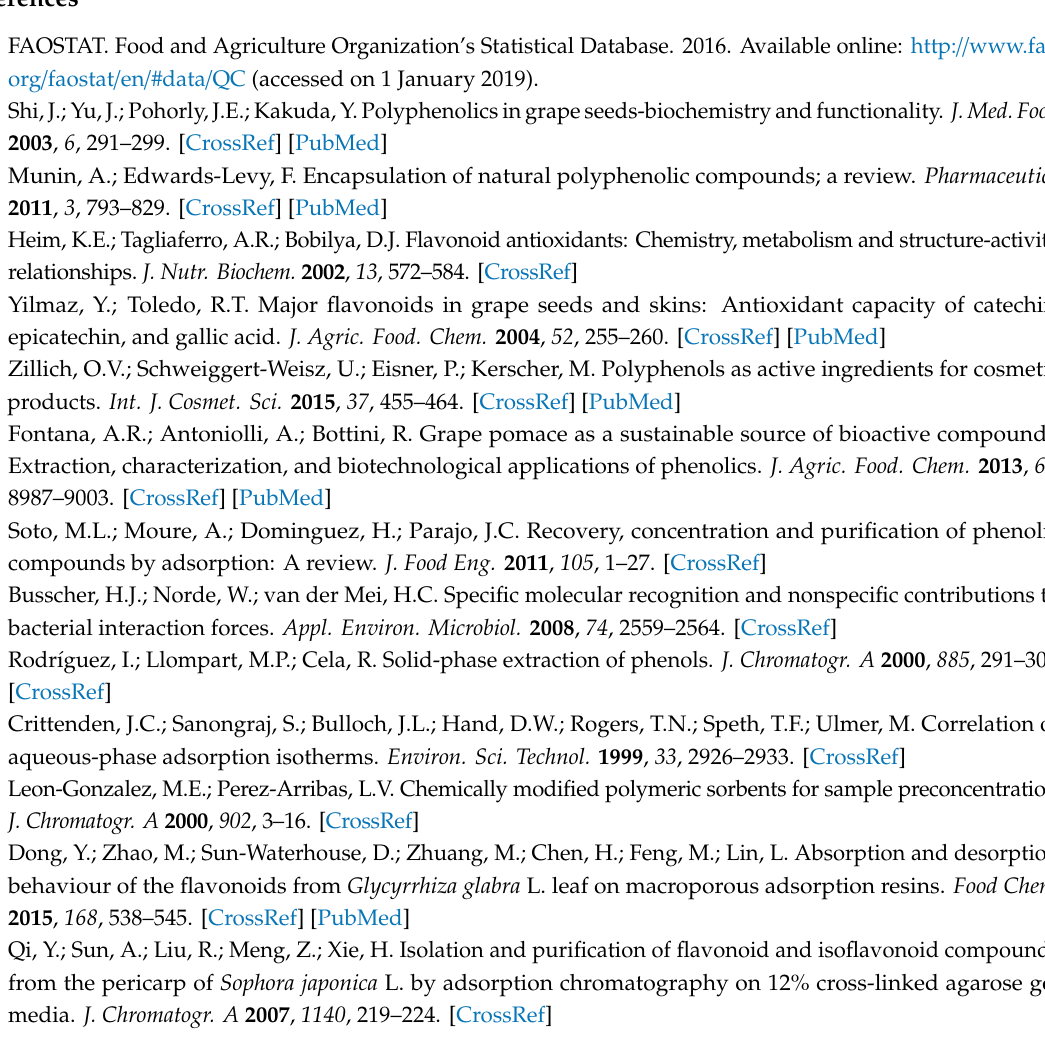
Supplementary Materials: The following are available online, Table S1: Individual phenolic compounds of grape pomace